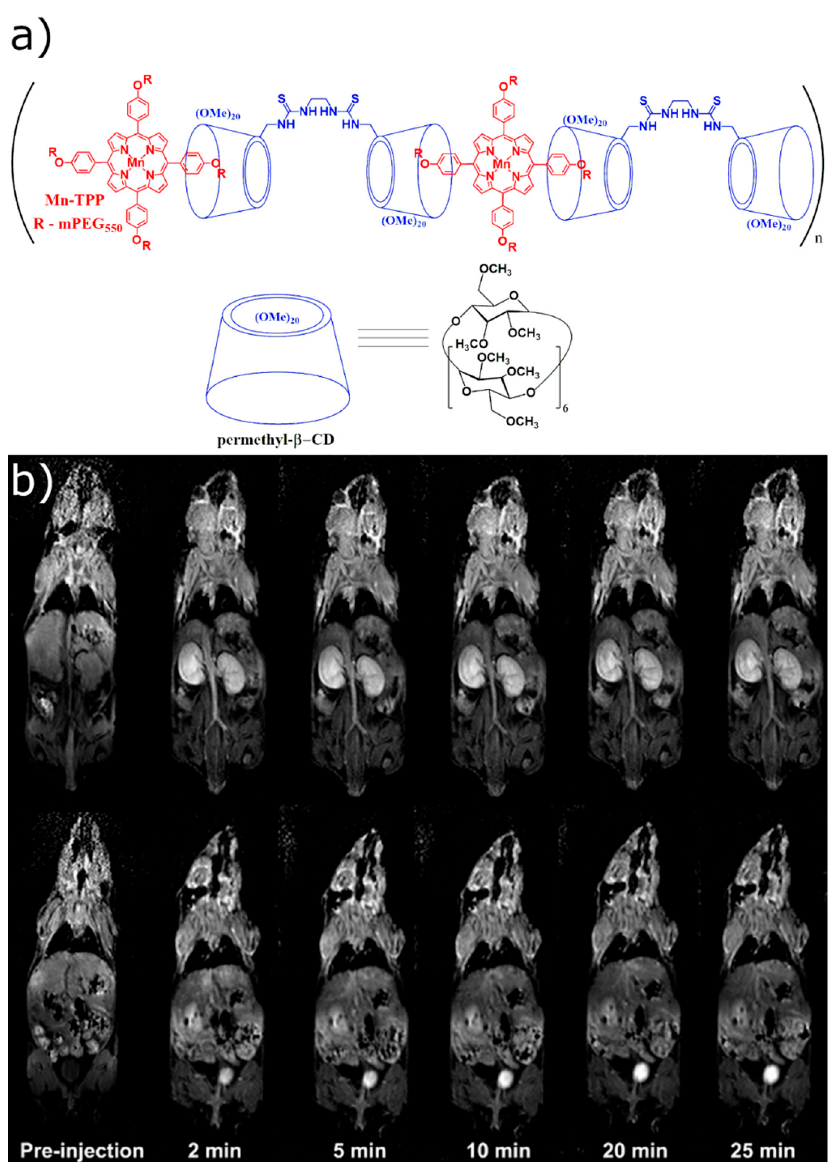
Figure 2. ( a ) Molecular structure of Mn(II)-TPP and bridged bis(permethyl- β -CD)s polymer. ( b ) Representative 2D coronal T1-weighted MR images of the mice at 2, 5, 10, 20, and 25 min after intravenous injection of Mn(II)-TPP/bridged β -CD magnetic resonance imaging (MRI) contrast agents at 0.03 mmol of Mn/kg [63]. The images are reprinted with permission from publisher [63].